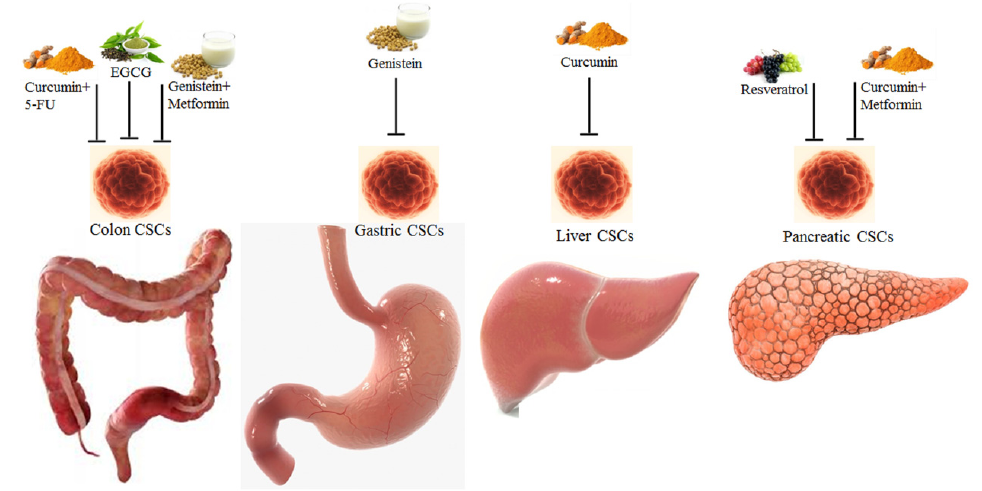
Figure 2. Phytochemicals and combinations of phytochemicals and drugs targeting the colon, gastric, liver and pancreatic CSCs [138].